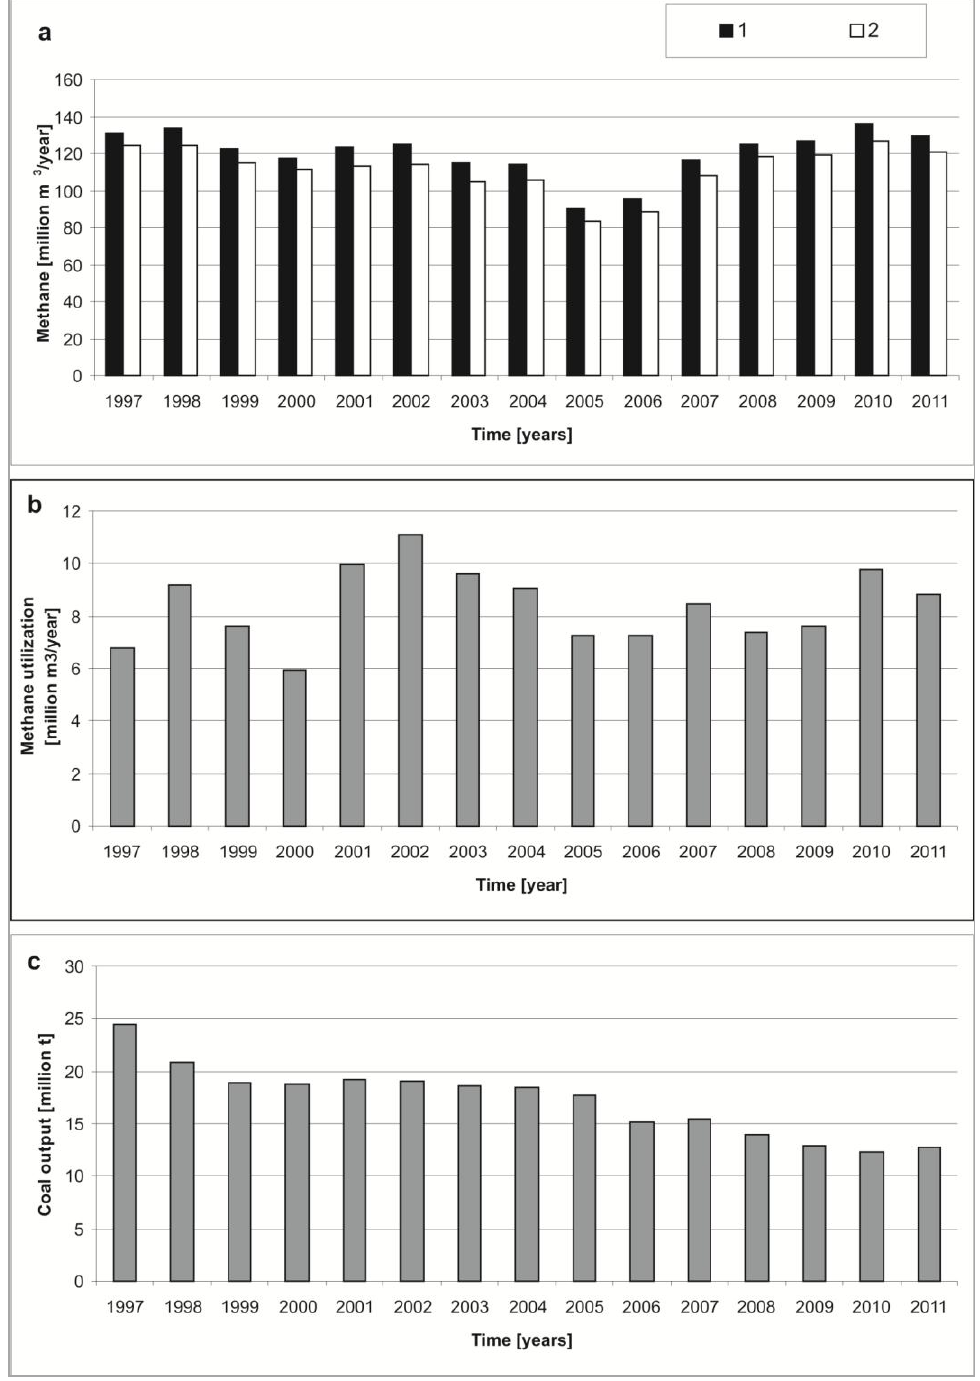
Fig. 3. Methane emission (a), utilization (b) from the mines of Katowice Coal Company compared to coal output (c), after Krause & Sebastian